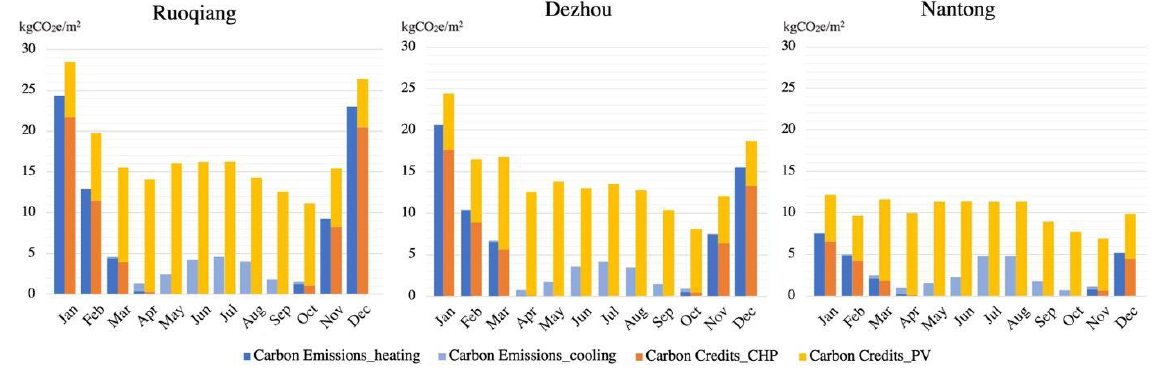
Figure 5 Monthly carbon emissions and credits during the operation